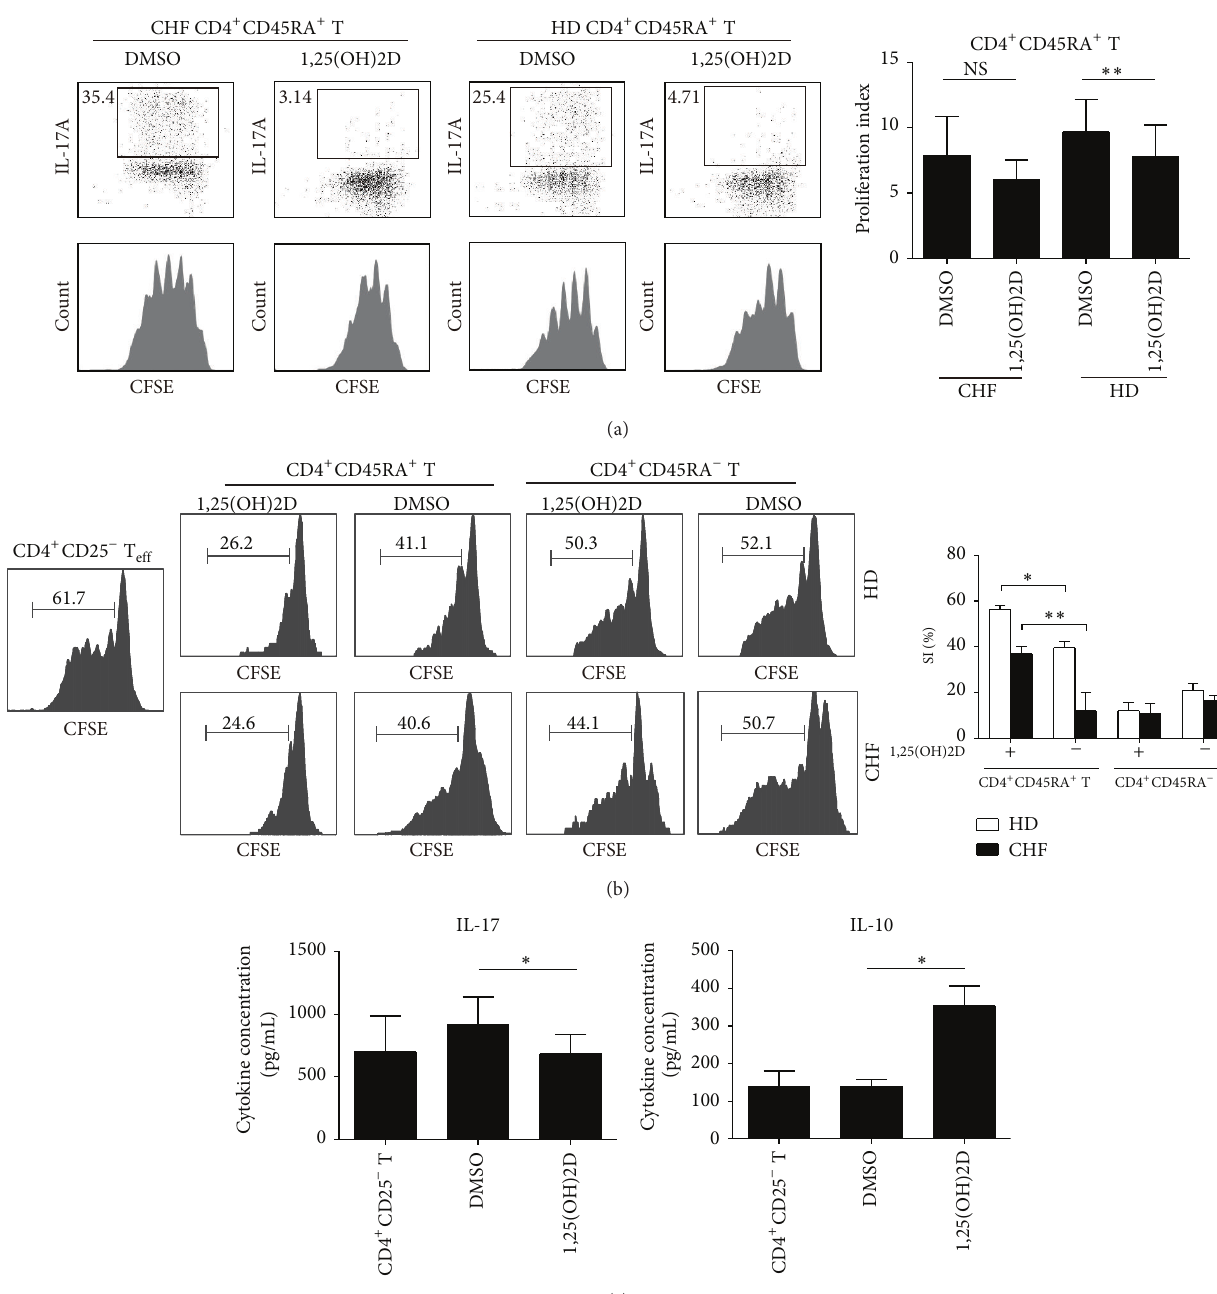
Figure 7: 1,25(OH)2D ameliorates the impaired immunomodulation of CD4 + CD45RA + T cell. (a) CD4 + CD45RA + T cells were purified from HD and CHF, labeled with CFSE subsequently, and incubated with 1,25(OH)2D or DMSO for 5 days. Representative flow cytometric dot plots and histograms of CFSE and IL-17A double staining. (b) Suppression of responder T cell proliferation was preceded using transwells. 1,25(OH)2D induced CD4 + CD45RA + T or CD4 + CD45RA − T cells were placed into top chamber while CD4 + CD25 − T cells were added into bottomchamber.After5days,cellswerestainedforCD4andproliferationofCFSE-labeledresponderTcellswasanalyzedonaflowcytometer. (c)ThelevelofIL-10andIL-17inculturesupernatantonday5wasdetectedbyELISA.Dataarerepresentativeoffiveindependentexperiments. Results shown are the mean ± SEM; * 𝑃 < 0.05